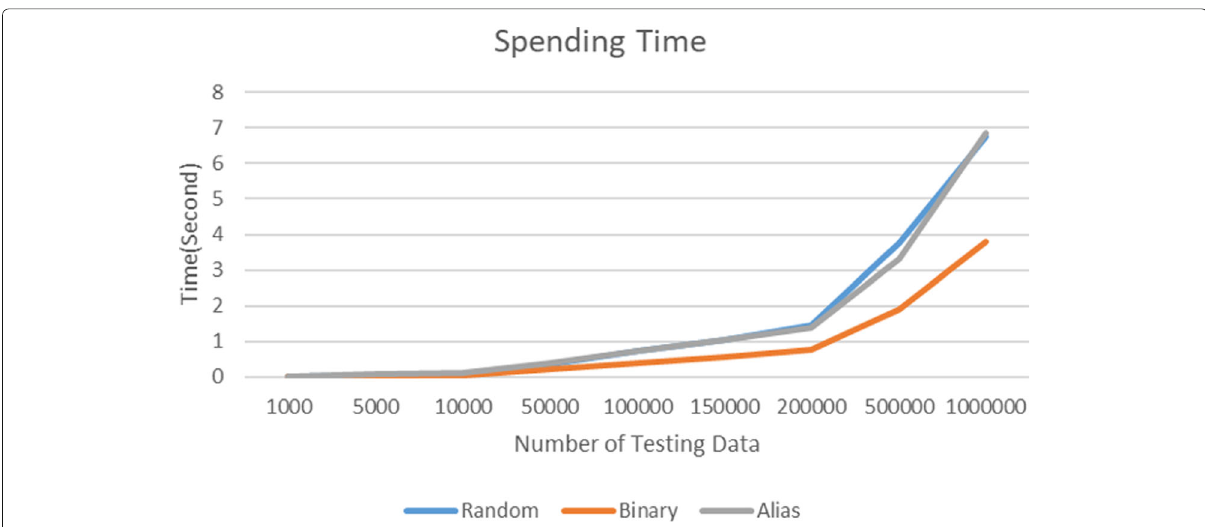
Fig. 14 The comparison of spending times. Comparison of the spending times of the random selection method, Alias method, and binary search